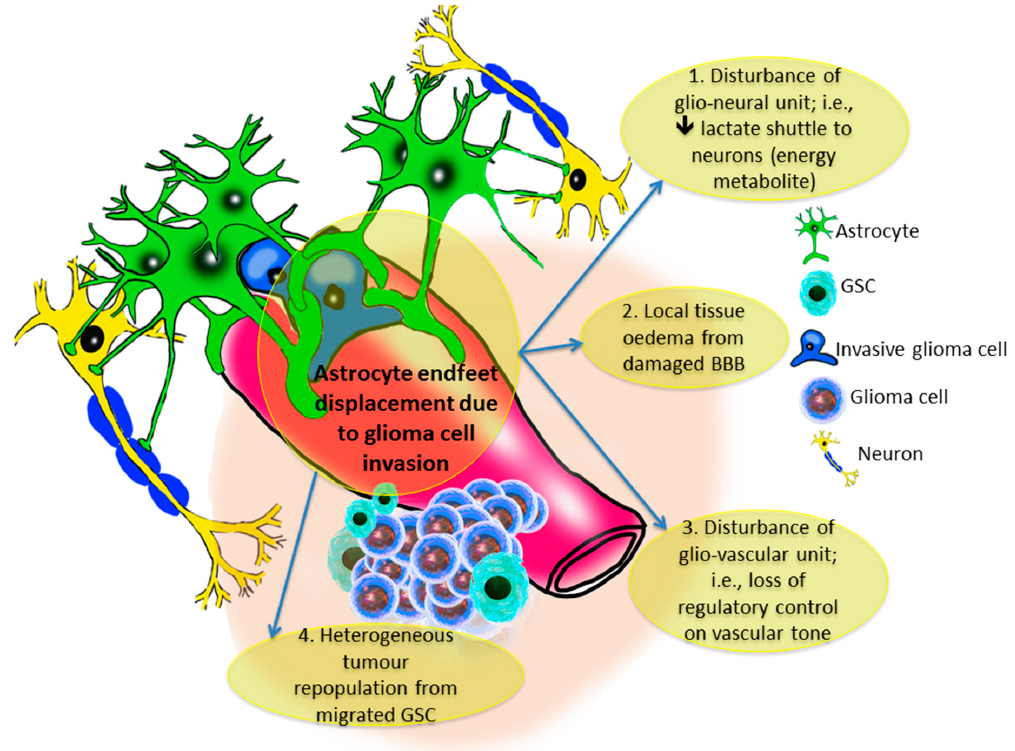
Figure 2. Astrocytic end-feet retraction due to the perivascular invasion of glioma tumour cells and/or glioma stem cells (GSCs). The function of both glio-neural and glio-vascular units are affected, leading to an increase in the neural excitotoxicity of neural tissue. Such toxicity includes local tissue oedema, vascular tone dysregulation and tumour repopulation from migratory GSC.